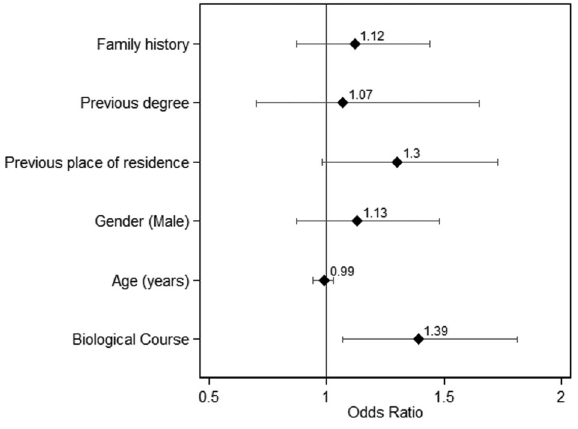
Figure 1. Odds ratio and 95% con fi dence interval among fi rst- year undergraduates at the University of São Paulo